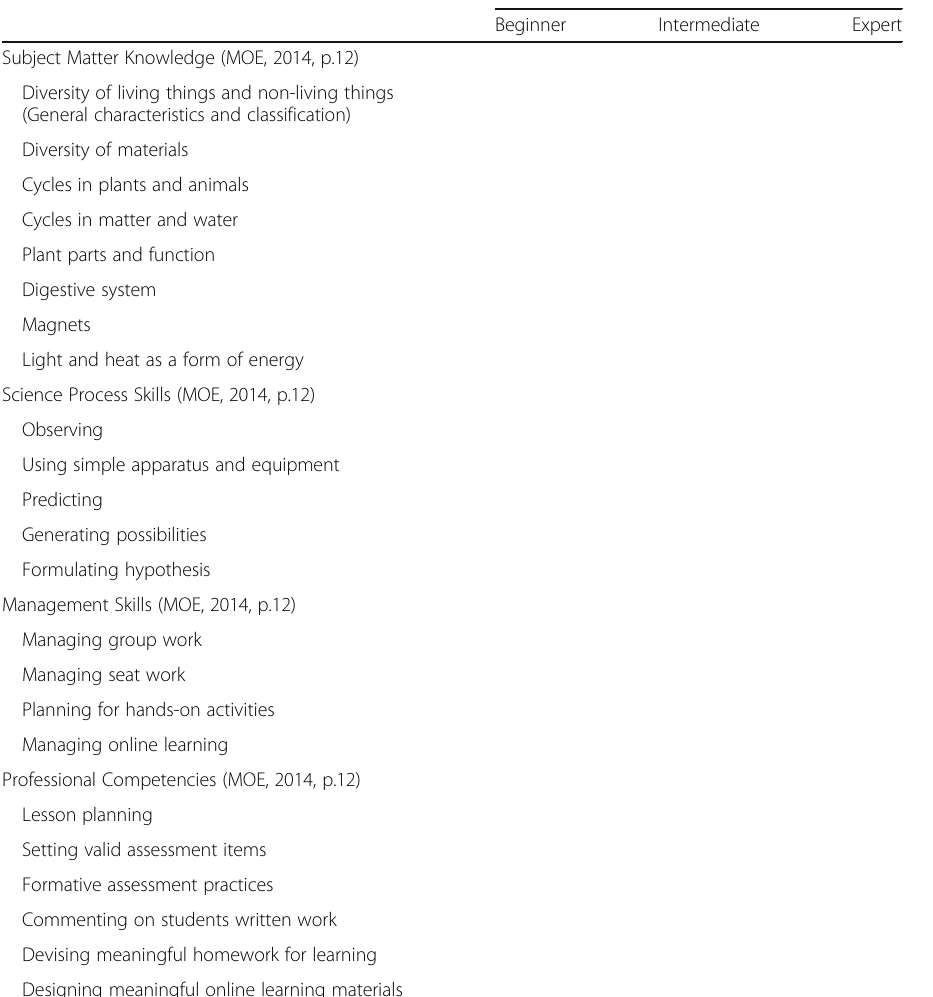
Level of attainment Beginner Intermediate Expert